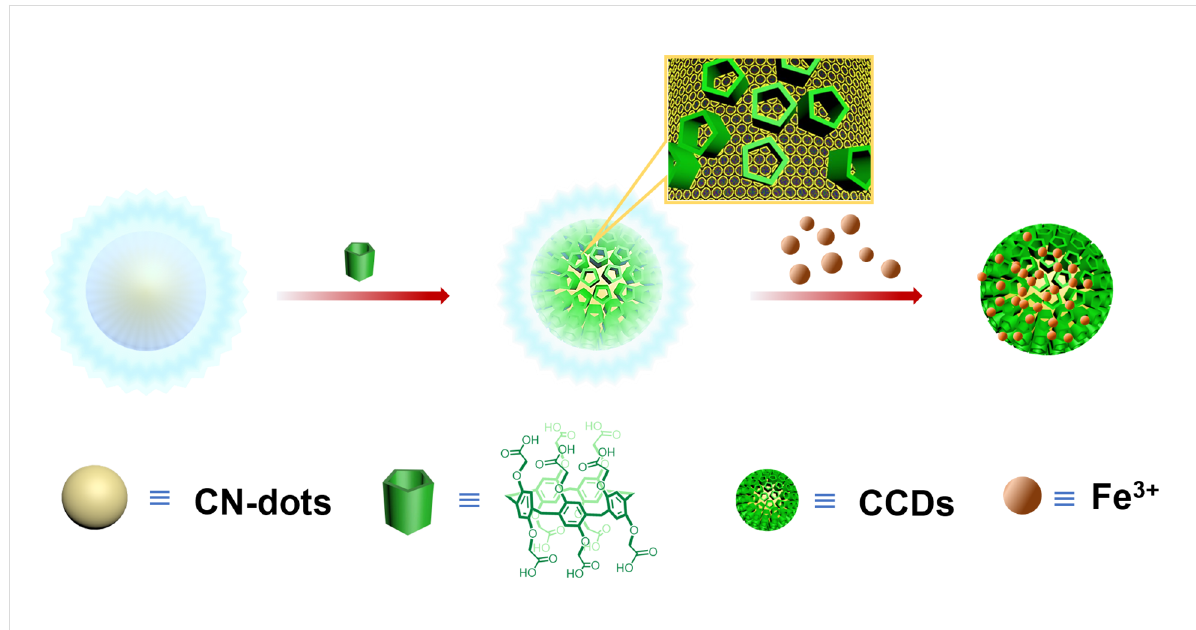
Scheme 1: Schematic illustration of the synthesis of CCDs and its use for Fe 3+